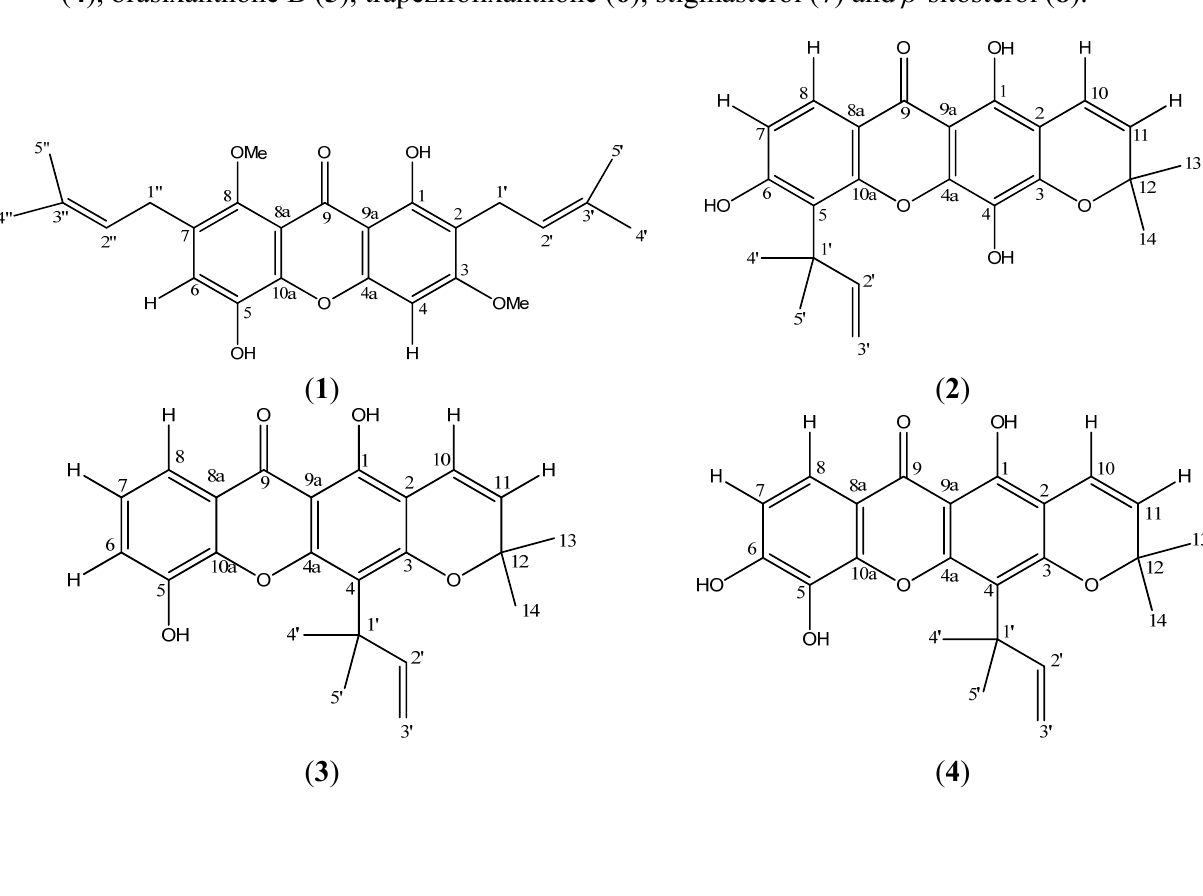
Figure 1. Structures of phylattrin ( 1 ), soulattrin ( 2 ), caloxanthone C ( 3 ),